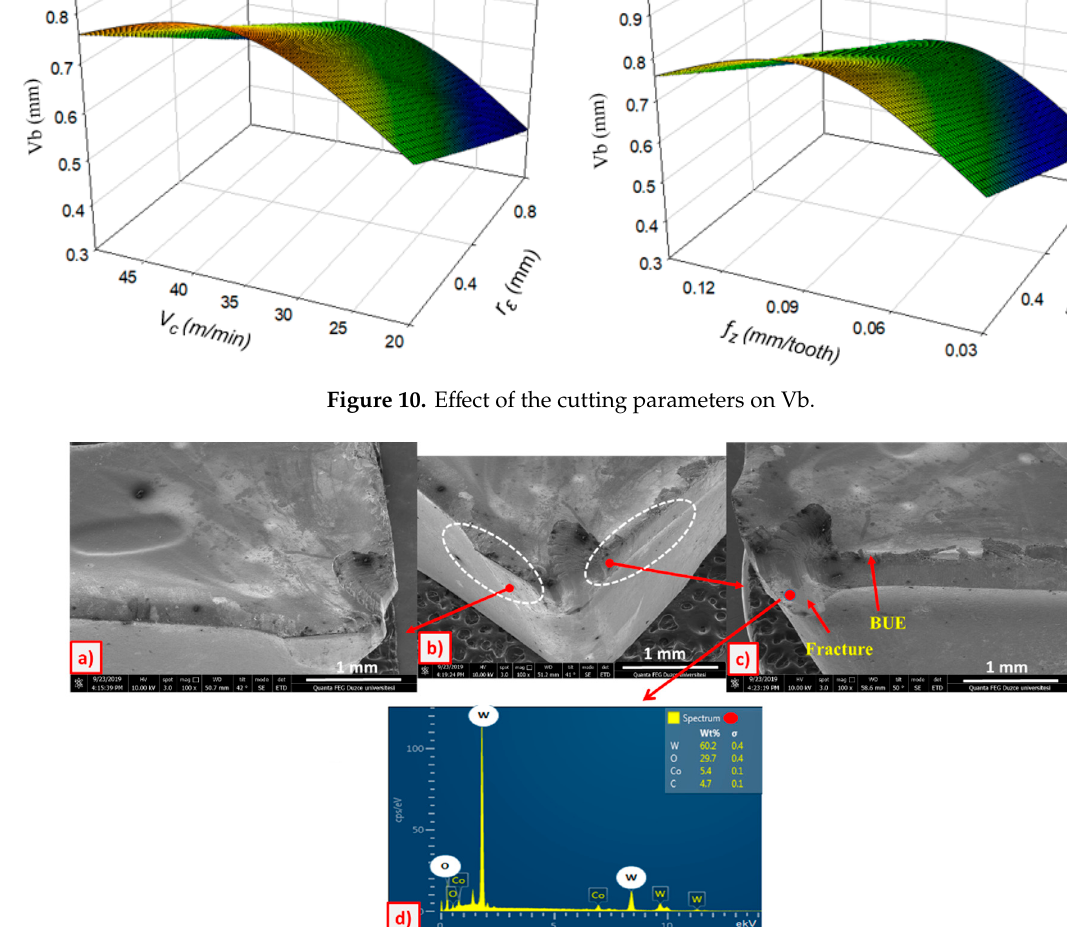
Figure 10. Effect of the cutting parameters on Vb.